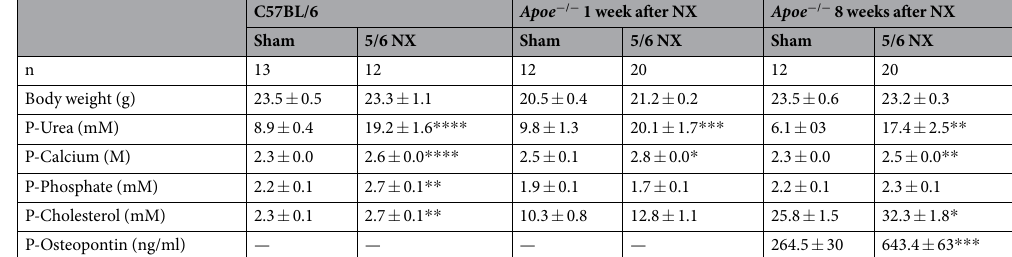
Table 1. Basic characteristics of uremic (5/6 NX) and sham-operated (sham) mice. Values represent mean ± SEM. * p < 0.05; ** p < 0.01; *** p < 0.001; **** p < 0.0001; Sham vs 5/6 NX,